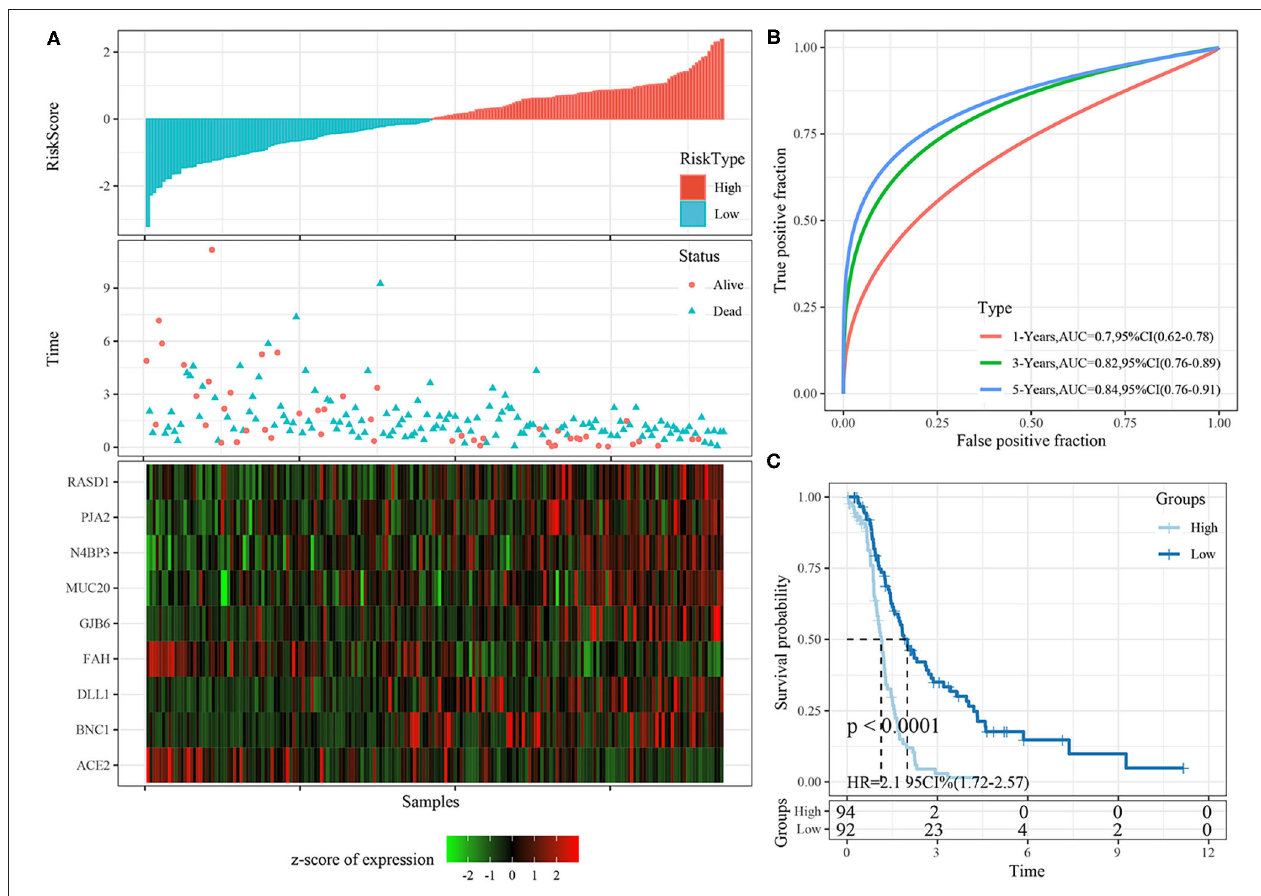
FIGURE 7 | (A) The distribution of risk score, survival time, and the expression of 9-gene in TCGA training cohort; (B) The ROC curve of 9-gene signature in training cohort; (C) The KM survival curve of 9-gene signature in training cohort.